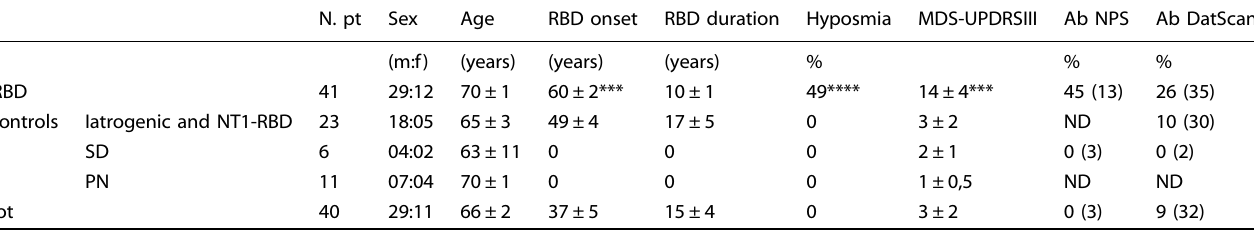
Table 1. Clinical and demographic characteristics of recruited